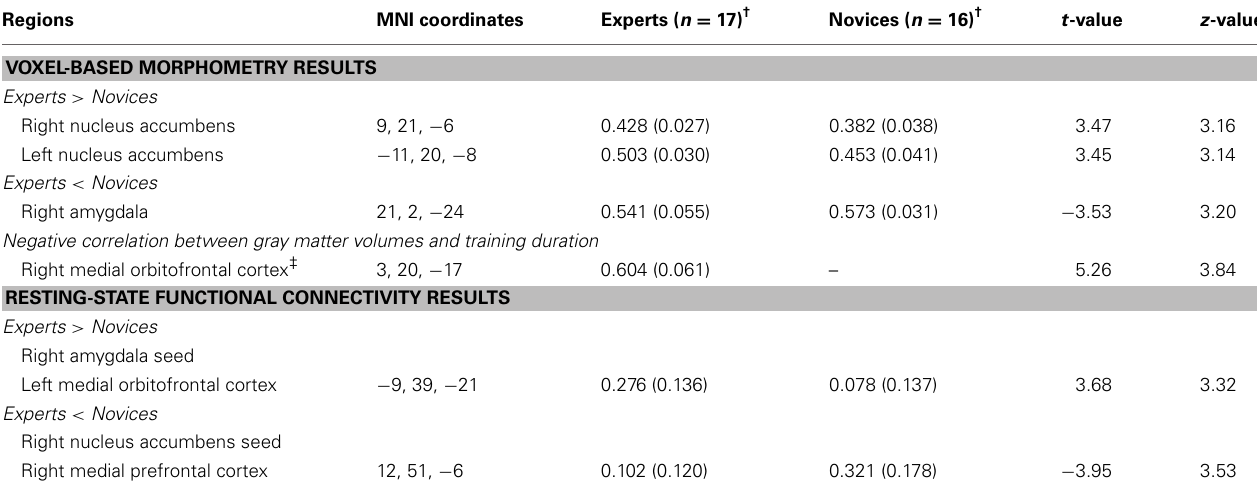
Table 2 | Regions showing significant group differences in gray matter volume and functional